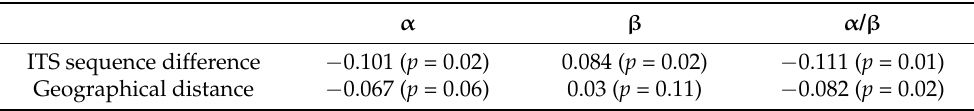
Figure 4. ITS haplotype networks inferred by PopART from 30 local populations of Yunnan. Notes: Each pie chart represents single or combined haplotypes. Because we used the haplotypes inferred by the PHASE software to construct the network, the PopART combined the several haplotypes with small base differences into one pie. Circle sizes indicate haplotype frequencies (number of individuals), and colors indicate the geographic populations of where the haplotypes are found. Solid lines indicate a single nucleotide substitution, and closed circles the missing haplotypes. Table 2. Results of Mantel tests between differences of individual copy numbers of α , β introns, or their ratio, and ITS sequence difference or specimens’ geographical